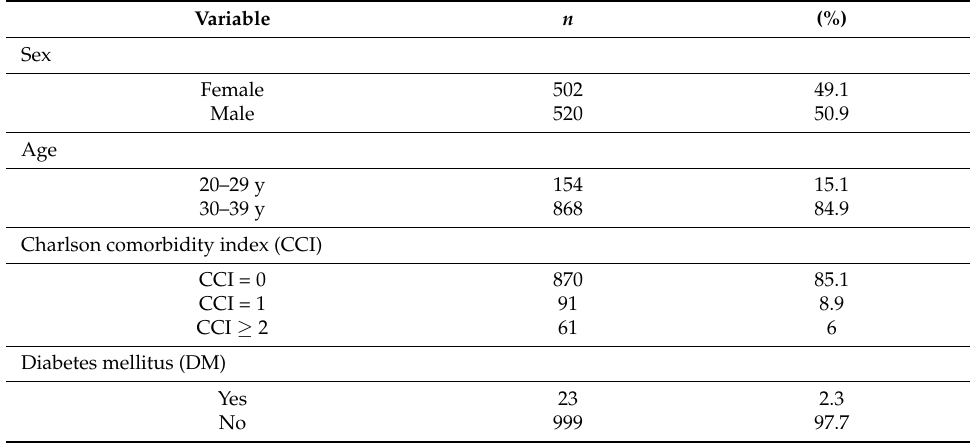
Table 1. Demographic information of the study sample ( n =